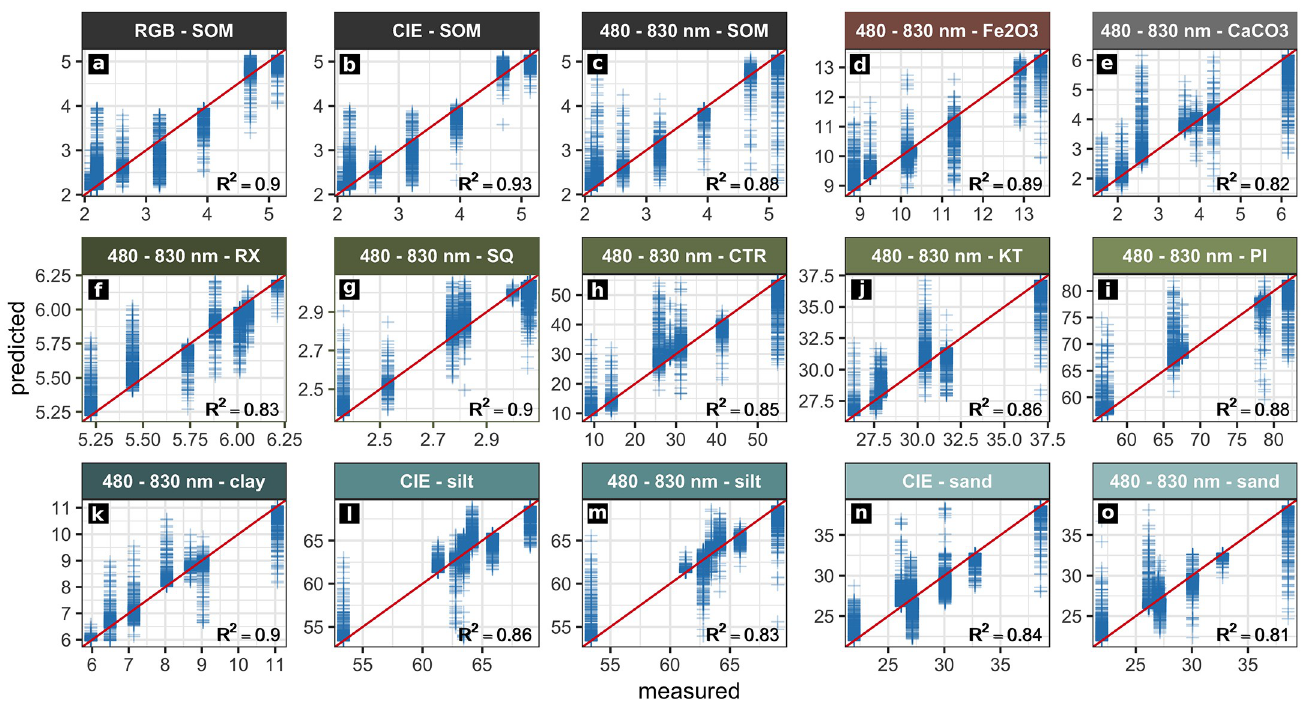
Fig 4. Results from regression analyses of profile EI. Actual (measured) and predicted values of the sediment properties examined. The ideal performance is shown by the red line (y = x). Only models with a cross-validated R 2 greater than 0.8 and a high correlation between the respective prediction map and the stratigraphic delineation are